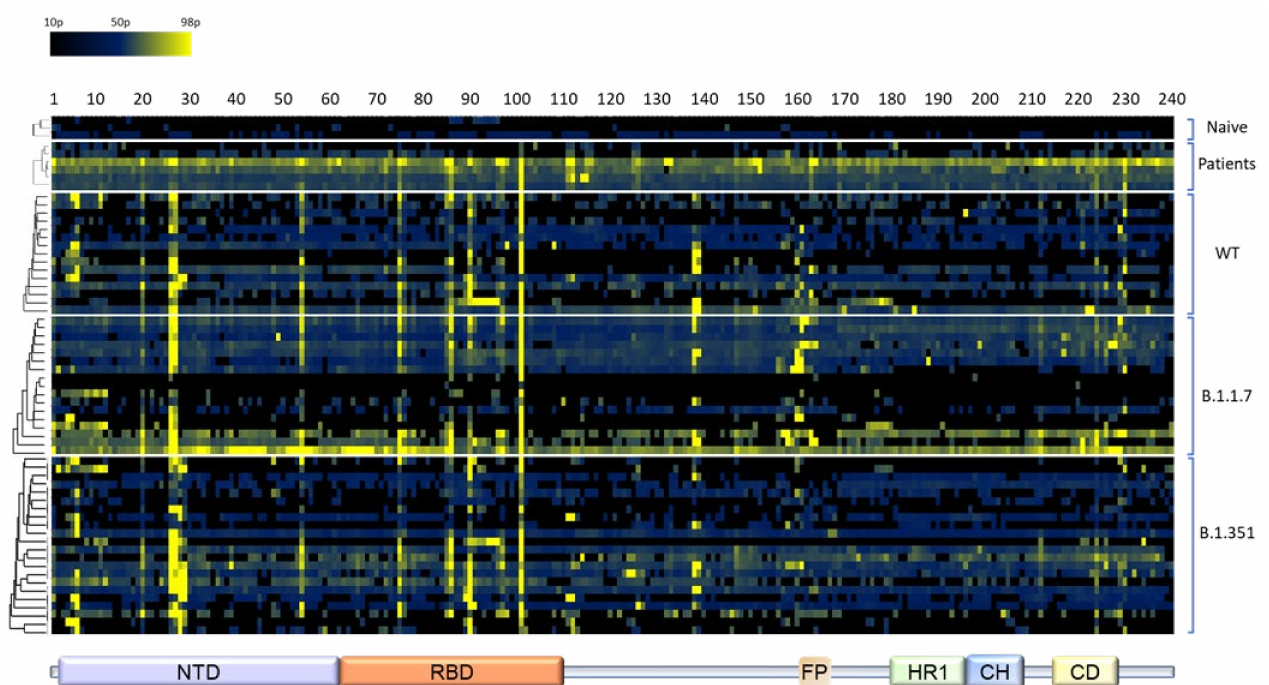
Figure 2. Heatmap plot of the binding results for the 240 peptides with various sera samples. Absorbance values at 405 nm marking the binding of convalescent serum antibodies to each one of the 240 peptides is presented by a heatmap. A graded 3-color scale of black (minimum—10th percentile), dark blue (midpoint—50th percentile) and yellow (maximum—98th percentile) was used. The peptide number is indicated on the top and the related spike domains depicted on the bottom. A hierarchal clustering using the average linkage method [29] was applied to the samples for each group in separate (top to bottom: naïve, COVID-19 patients, WT-infected mice, B.1.1.7-infected mice and B.1.351-infected